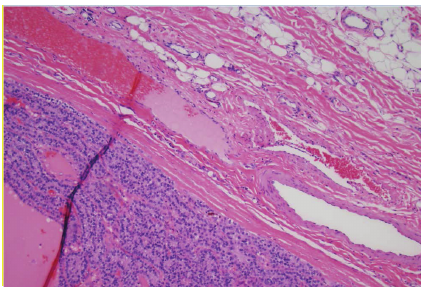
Figure2:Parathyroidtumorcytology,arrowshowingmitoticfigure.